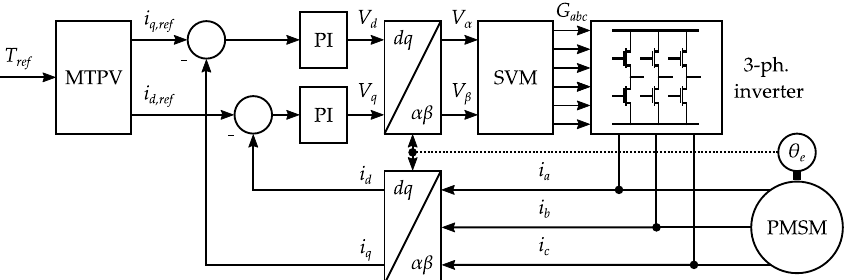
Figure 5. Field–oriented current control